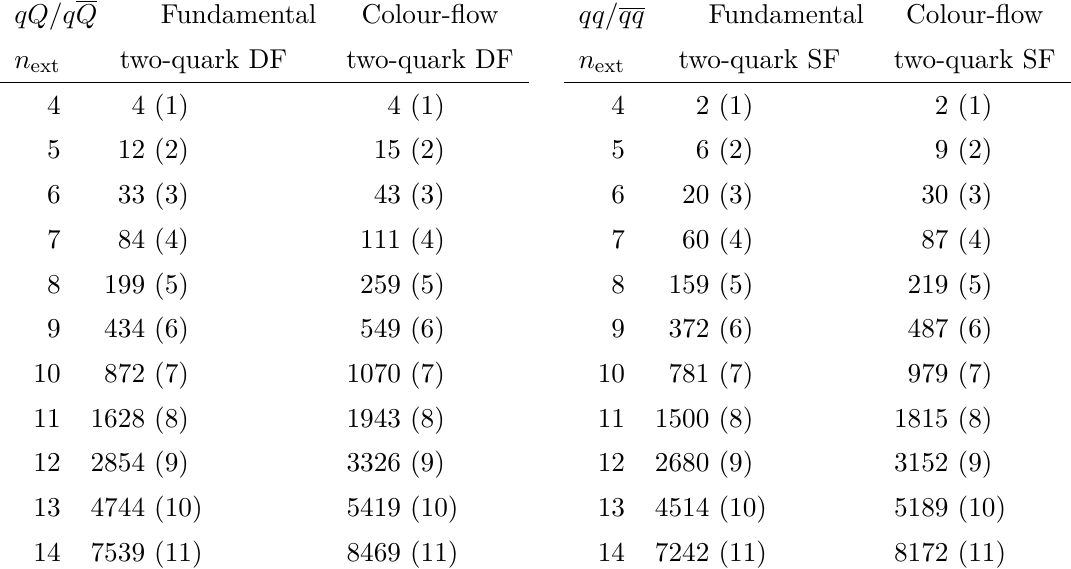
Table 10 . Number of non-zero elements in the colour matrix at NLC and at LC (in parenthesis) including the reduction due to the phase-space symmetrisation, for qQ/qQ (left) and qq/qq (right) initial states for two-quark-pair processes for various numbers of final-state particles ( n the fundamental and colour-flow